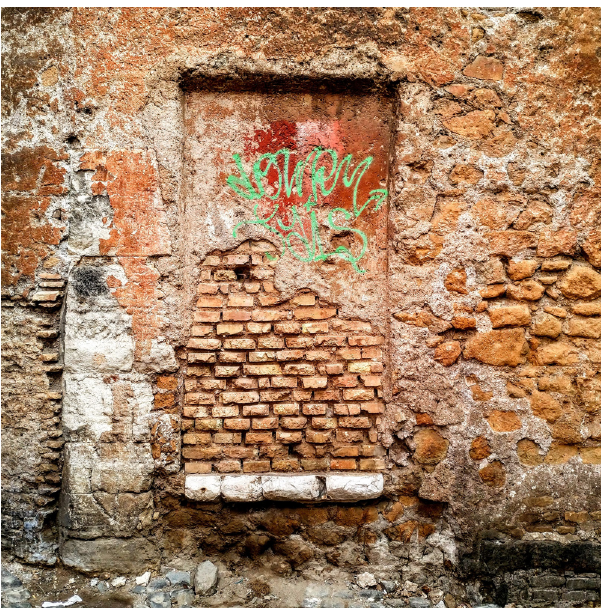
Figure 2: A new topography. Photograph by the author. Vicolo del Cedro, Rome. February 27,